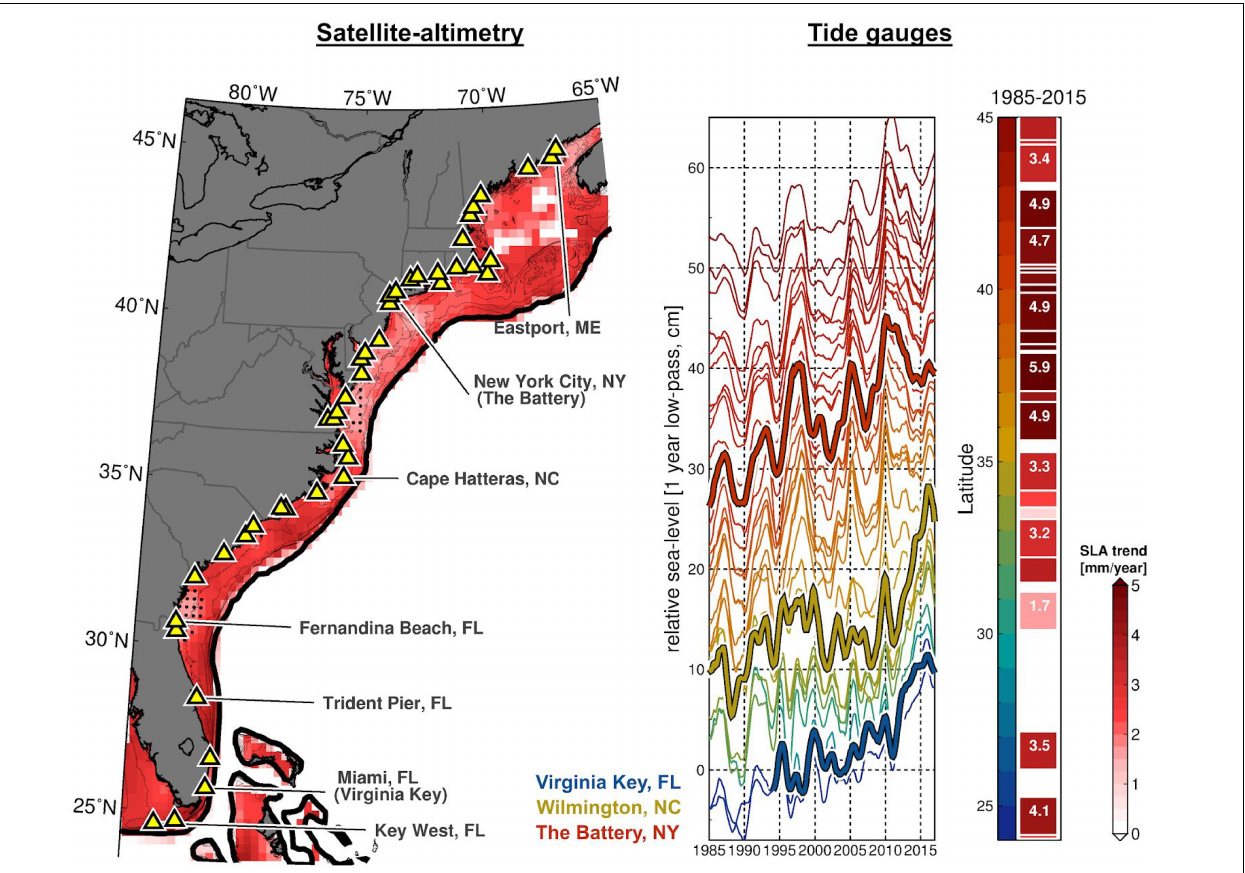
FIGURE 1 | (Left) Location of 43 tide gauges along the United States East Coast (yellow triangles) overlaid on SLR rates estimated from satellite-altimetry for the time period of 1993–2015. (Right) 1-year low passed time series of sea level observations at the 43 tide gauges along the United States East Coast. Time-series are offset by 1.5 cm between consecutive tide gauges for display purposes, and rates of SLR for individual tide gauges are shown to the right for the time period of 1985–2015.